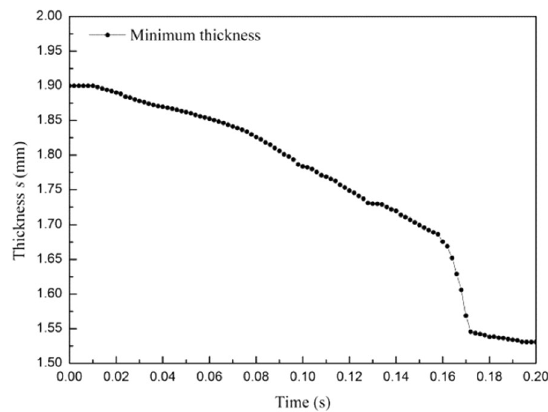
Figure 22 Time history curve of minimum wall thickness time history